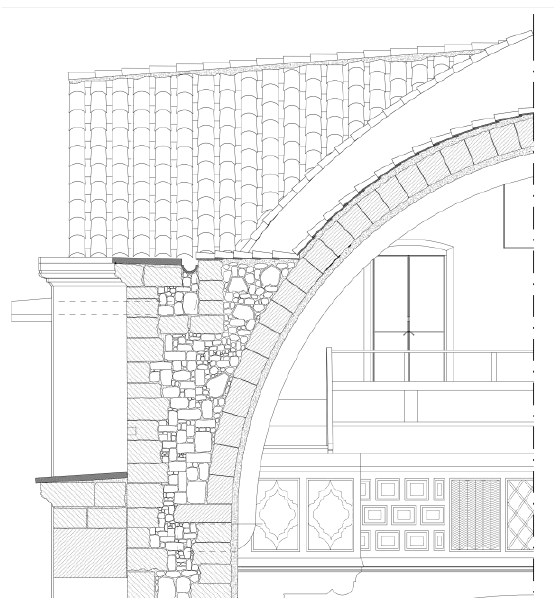
Figure 14. Transversal cross-section with masonry detail